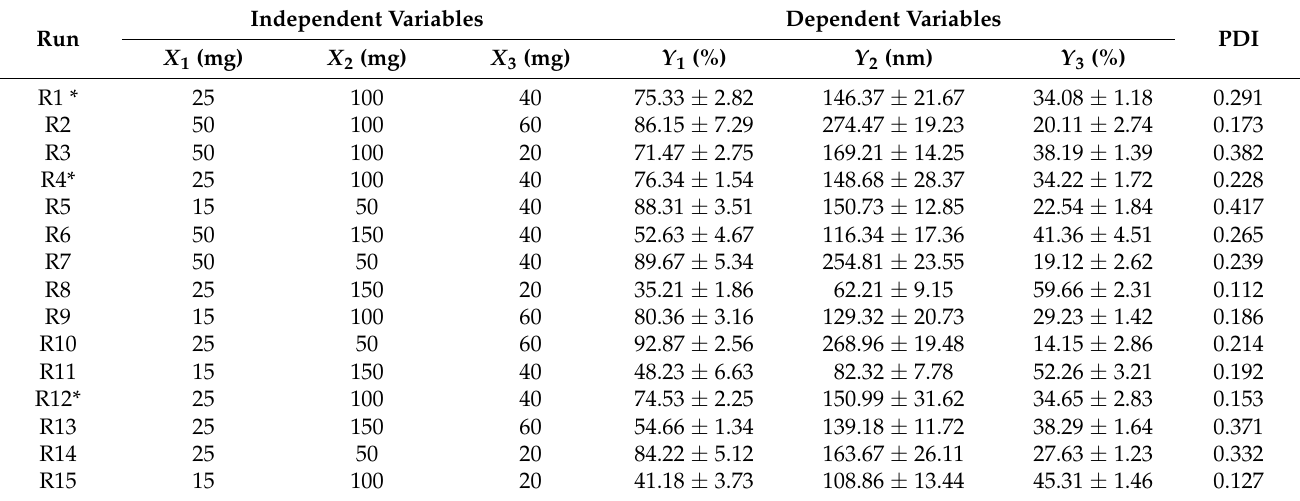
Table 2. QRC-NOVs experimental runs, causal factors, and observed responses based on the Box– Behnken